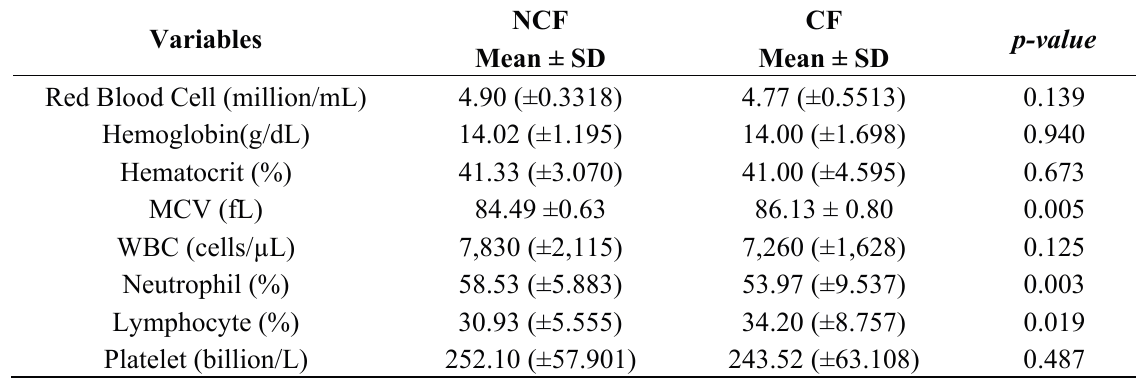
Table 3. Hematological values observed in NCF and